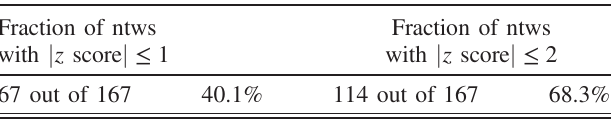
TABLE II. Fraction of networks whose discrepancy between the real and randomized nestedness is less than or equal to 1 σ or 2 σ for nestedness measured by the spectral